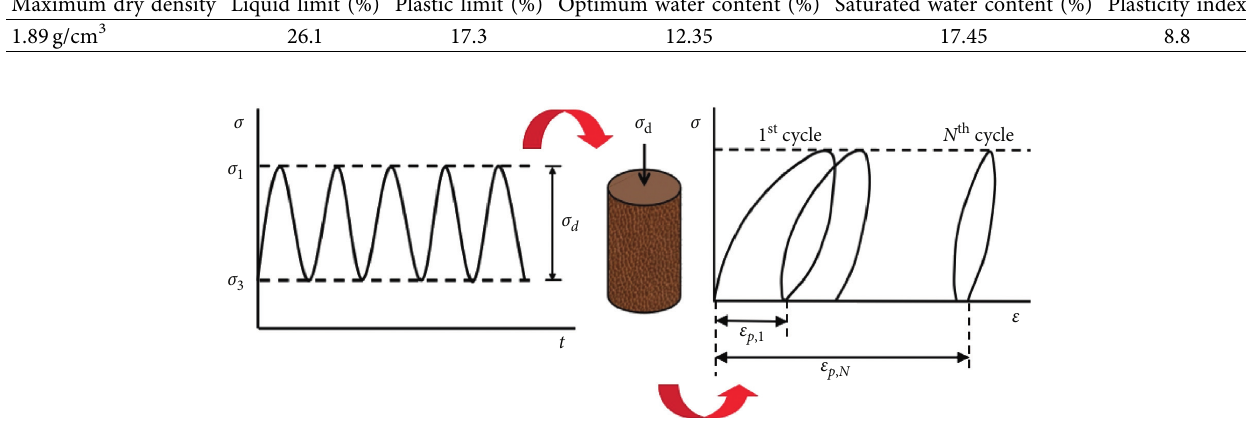
Figure 2: Axial strain of sample under long-term repeated cyclic loading. Table 2: Dynamic triaxial test condition of thawed soil.